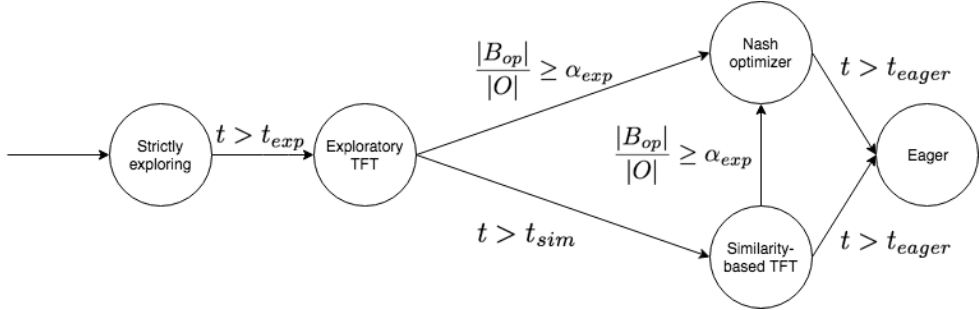
Figure 1. Finite state machine representing the behavior of the proposed social